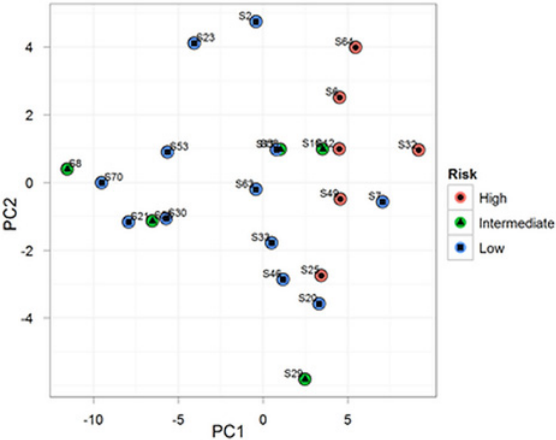
Fig 1. Principal components analysis. Principal components analysis performed on all samples using the top 50 miRNAs showing the highest standard deviation across all